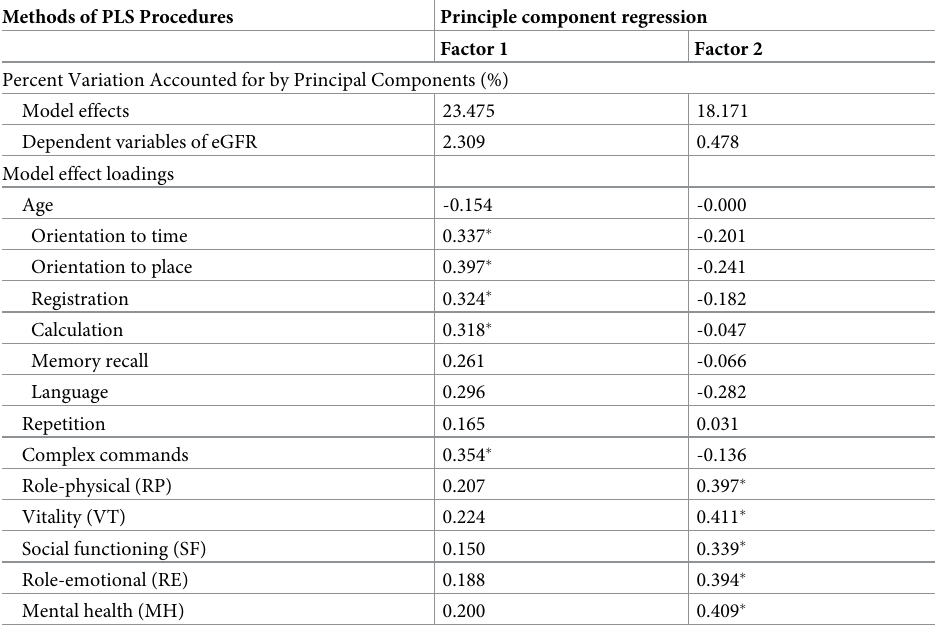
Table 5. Validation with partial least squares (PLS)